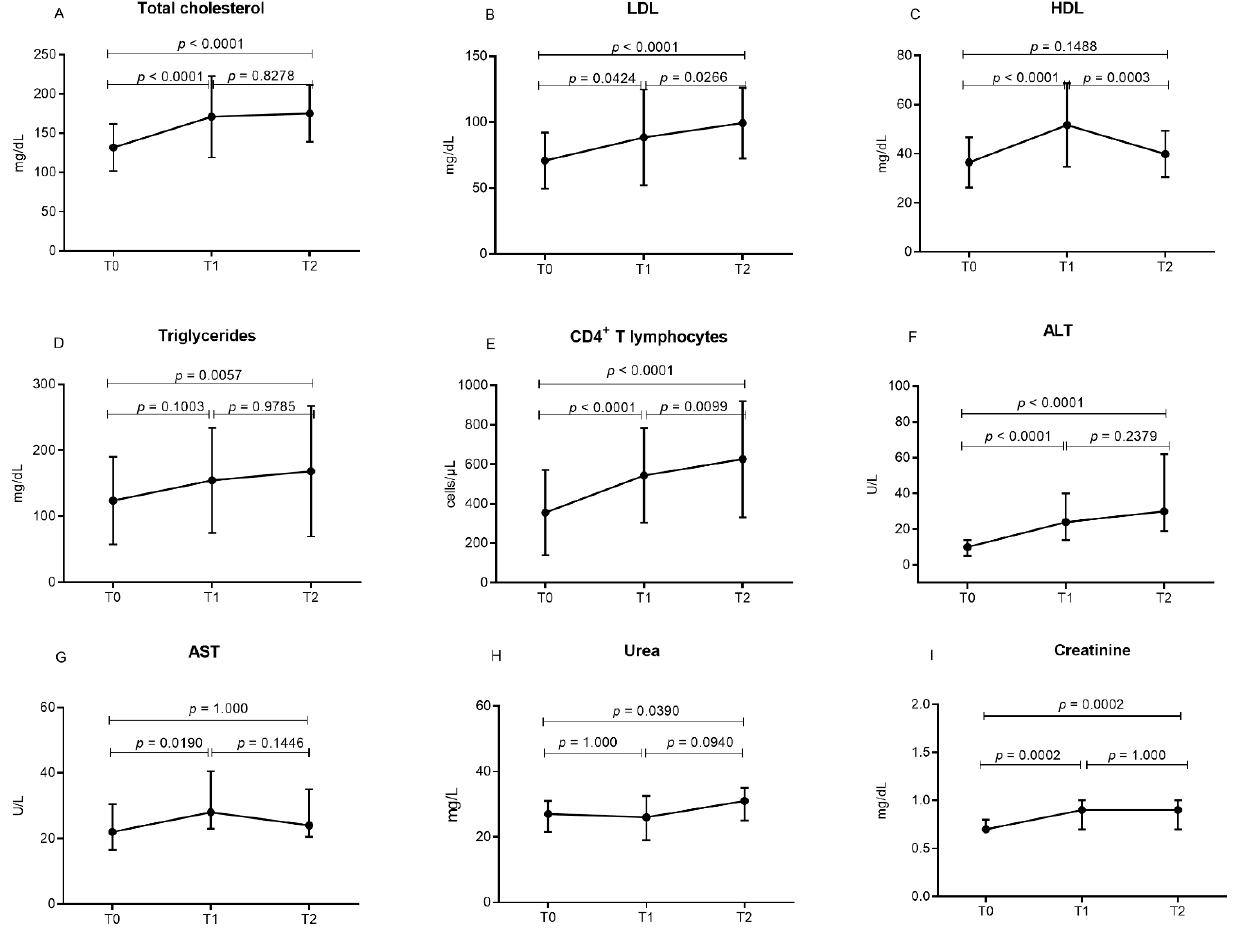
Figure 1. Comparison of the biochemical levels ( A ) total cholesterol, ( B ) LDL, ( C ) HDL, ( D ) triglycerides, ( E ) CD4 + T lymphocytes, ( F ) ALT, ( G ) AST, ( H ) urea and ( I ) creatinine of individuals with HIV1